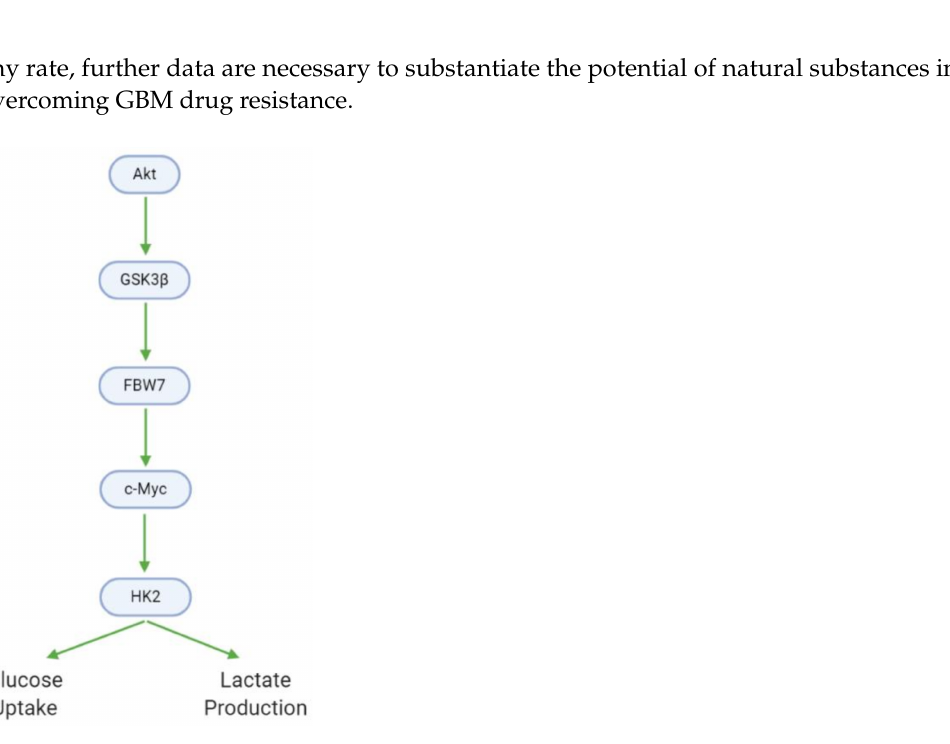
Figure 9. GBM cells utilize altered metabolic processes (Warburg effect) characterized by increased glucose uptake and lactate generation. Akt, via GSK3 β , mediates the transition between the healthy and Warburg phenotypes. Table 10. Xanthohumol, carnosine, and crocetin interfere with key enzymes in GBM cell metabolism.